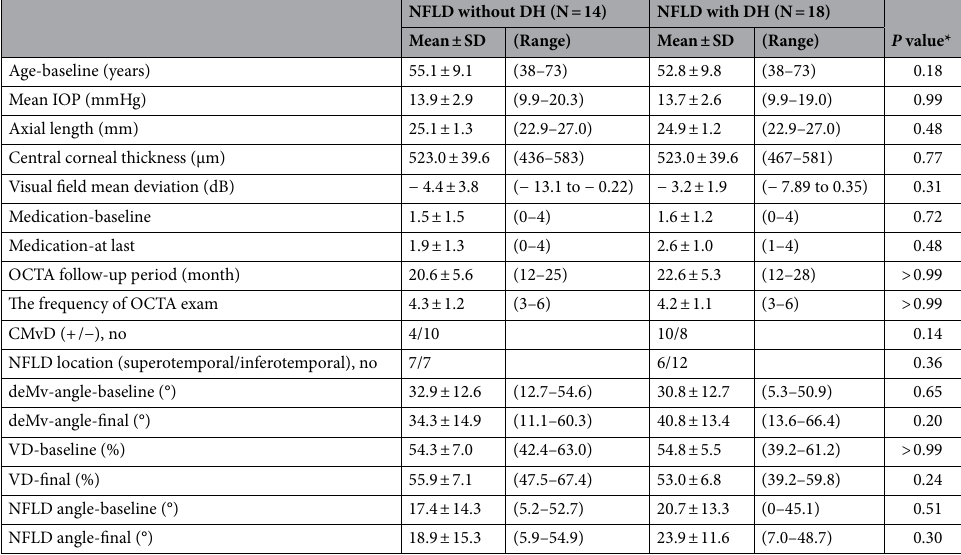
Table 2. Comparison of clinical characteristics between NFLD with DH and NFLD without DH (N = 32 NFLD locations). Data are presented as mean ± standard deviation (SD) with the minimum and maximum optical coherence tomography angiography, VD vessel density. *Analyzed using linear mixed-effect modeling between NFLD without DH and NFLD with DH.